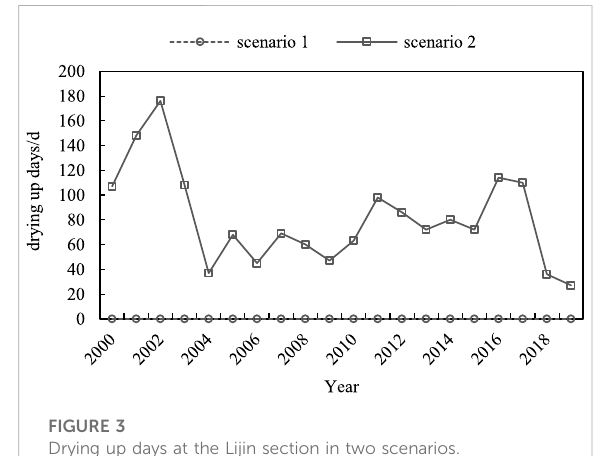
FIGURE 3 Drying up days at the Lijin section in two